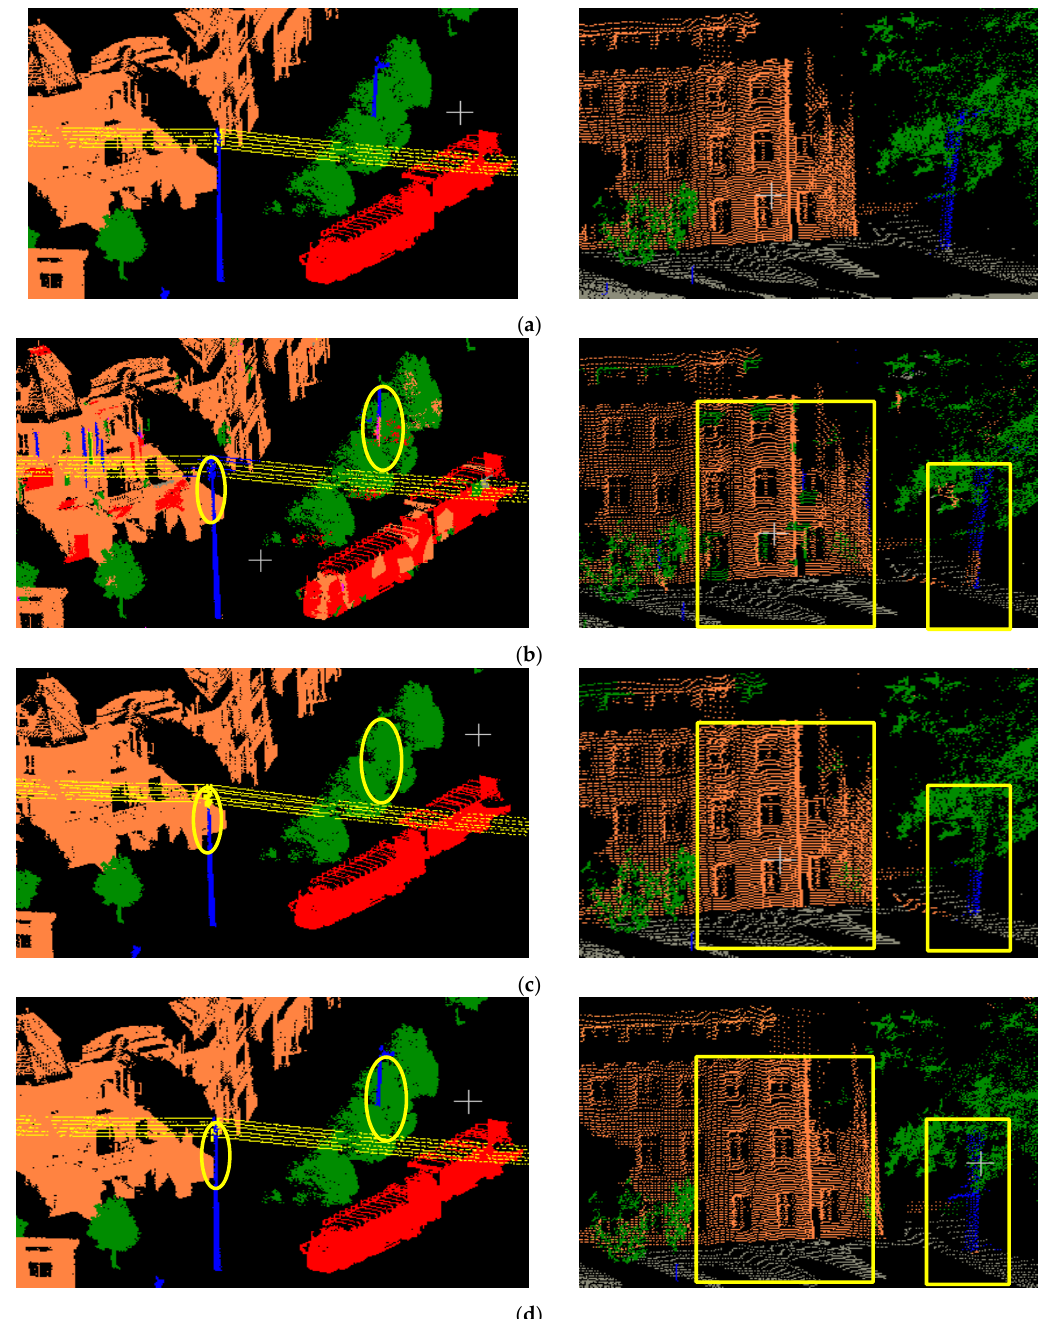
Figure 9. The initial scene semantic labeling and the comparison with the spatially smoothed results for selected point clouds.